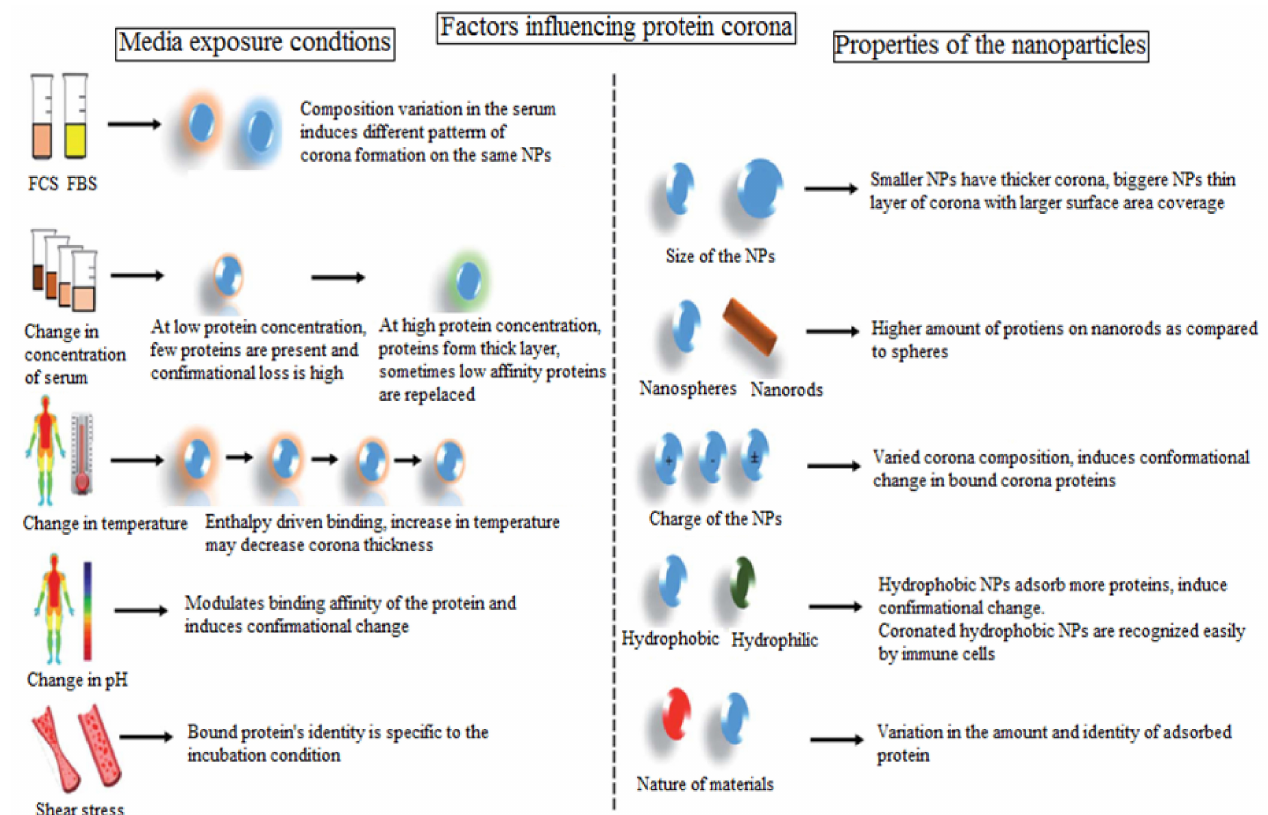
Figure 6. Influence of the properties of NPs and the incubation medium, temperature, and pH on PC formation. Permission under Creative Commons Attribution-Non Commercial 3.0 Unported License